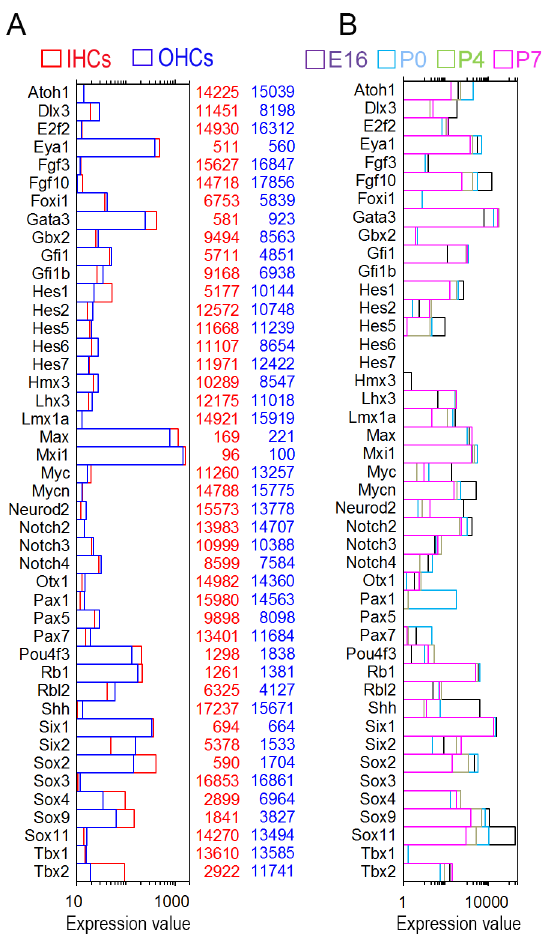
Fig 6. The expression levels of some TFs that are critical for hair cell and/or supporting cell development. (A) TFs in adult IHCs and OHCs. (B) TFs in nascent hair cells.